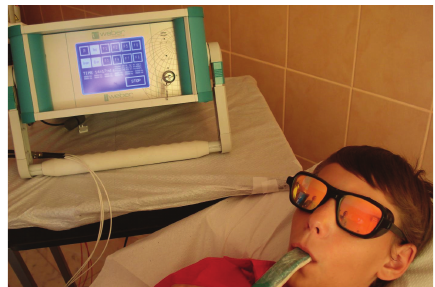
Figure 2: Patient during treatment with the Weberneedle Laser- shower Mouth Applicator, fromWeber Medical GmbH, Lauenf¨orde, Germany.